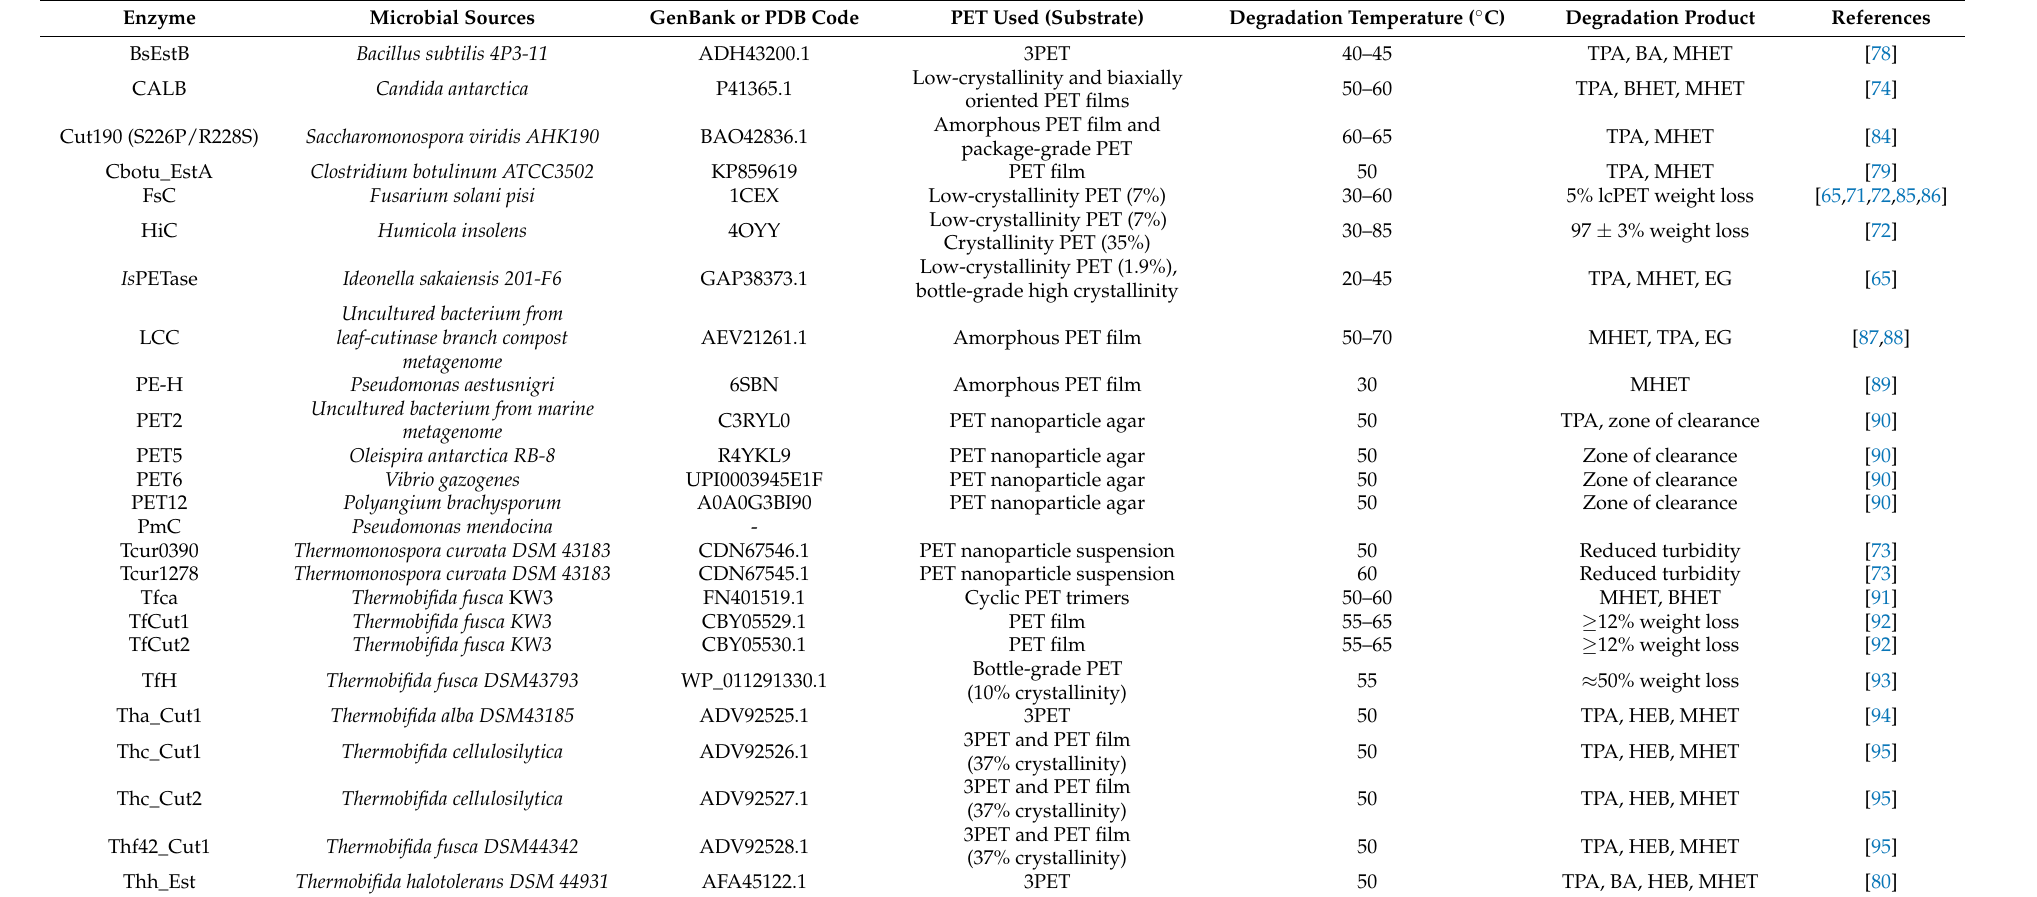
Table 2. Biochemically characterized known microbial enzymes linked to polyethylene terephthalate (PET) biodegradation. Enzyme Microbial